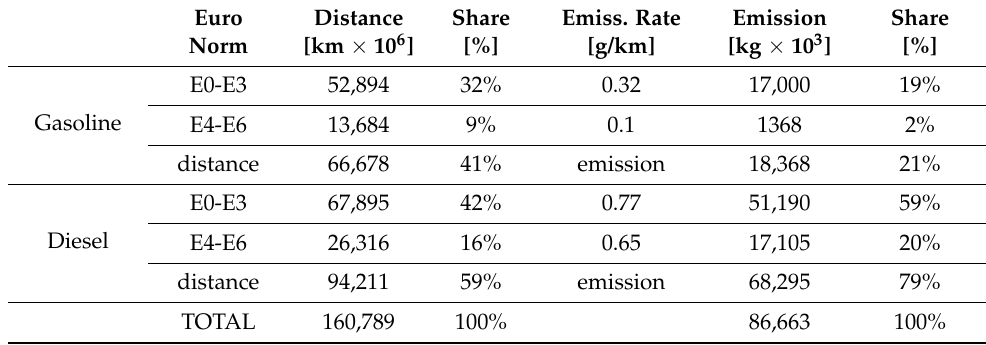
Table 1. Reference NO 2 passenger car emissions in Warsaw per fuel and Euro norm. Figure 4. Modifications of PM 10 exposure.